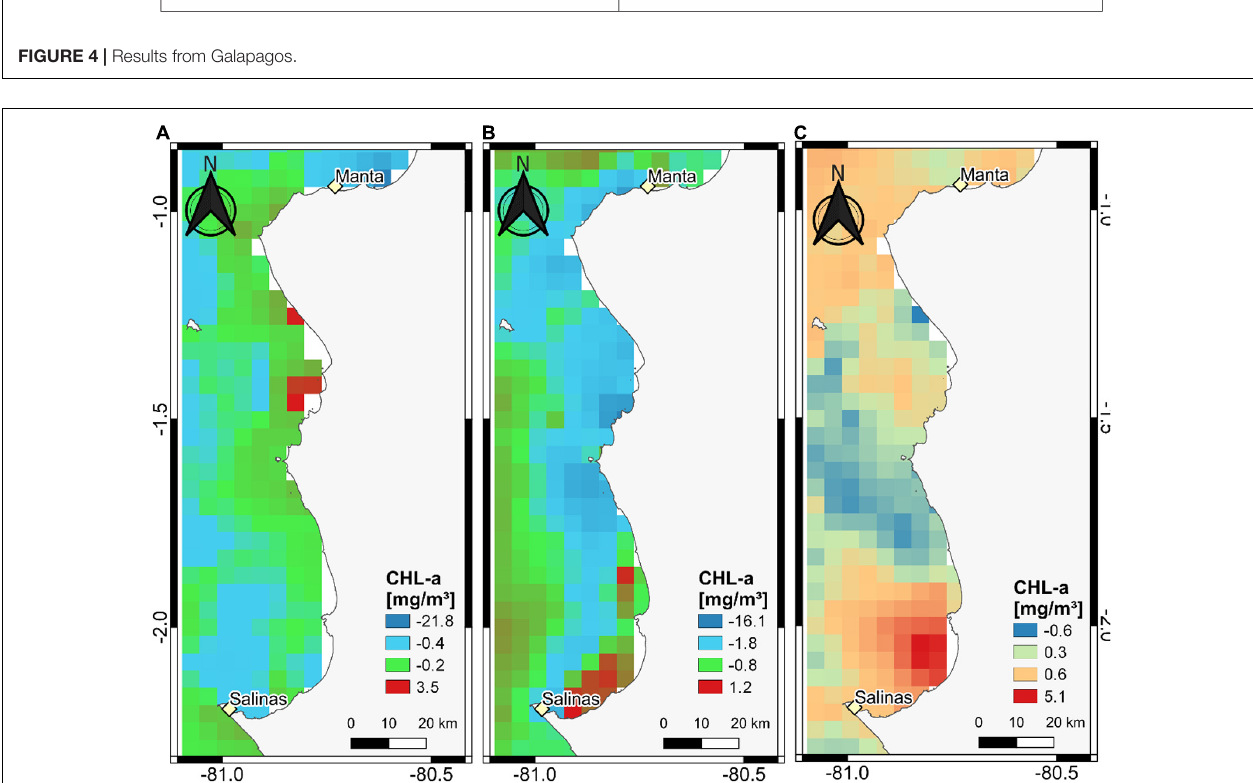
FIGURE 5 | (A-C) Satellite